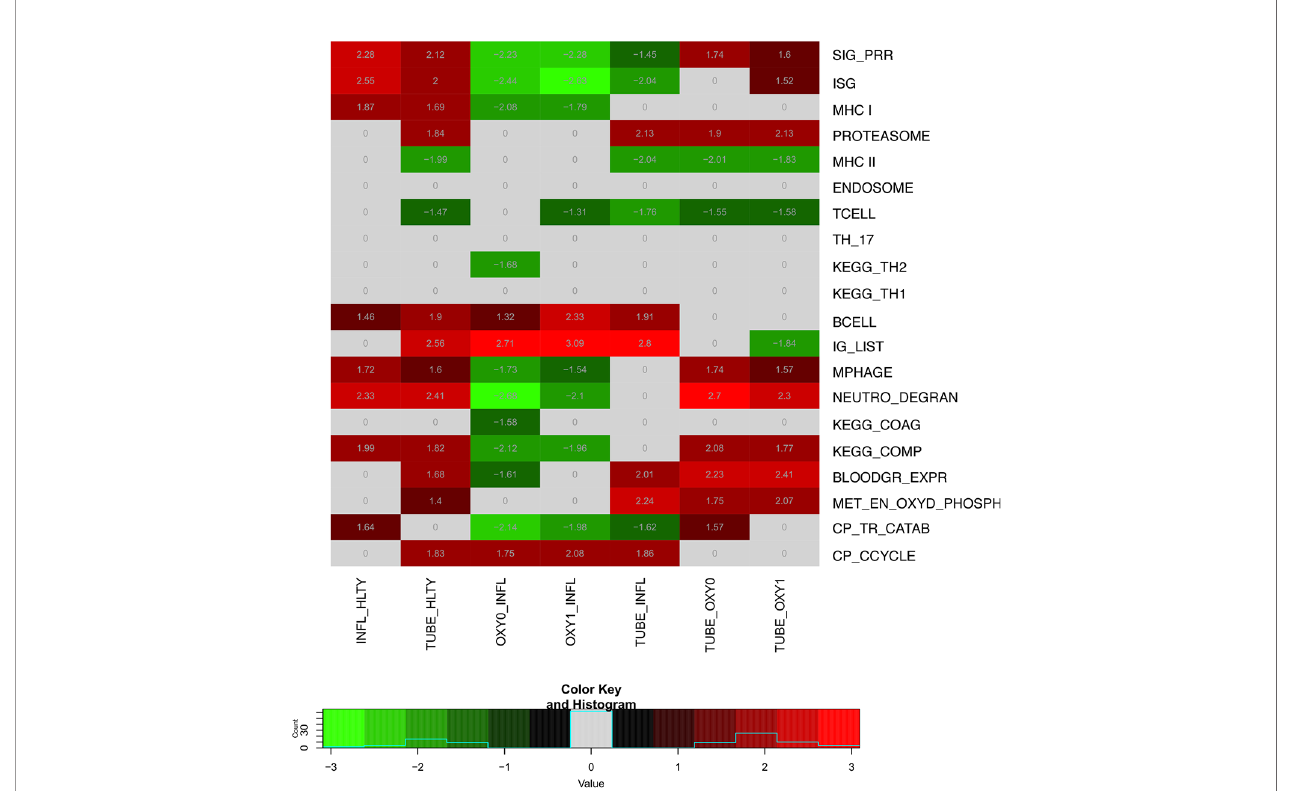
FIGURE 2 | Heatmap of differentially expressed genes (DEGs) sets for indicated pairwise comparisons. Groups used for comparisons (columns) include SARS-Cov- 2 infected patients with no oxygen support [OXY0], oxygen support [OXY1], intubation with sampling within 7 days (TUBE early) or >7 days (TUBE late) after hospital admission, In fl uenza virus (INFL) infected patients and non-infected controls (HLTY). Signi fi cantly (adj. P-Value <=0.05) enriched genes sets (rows) are selected from different GO, REACTOME and/or KEGG pathways (see Supplementary Table 2 ), and their normalized enrichment score (NES) is indicated in each cell and used for